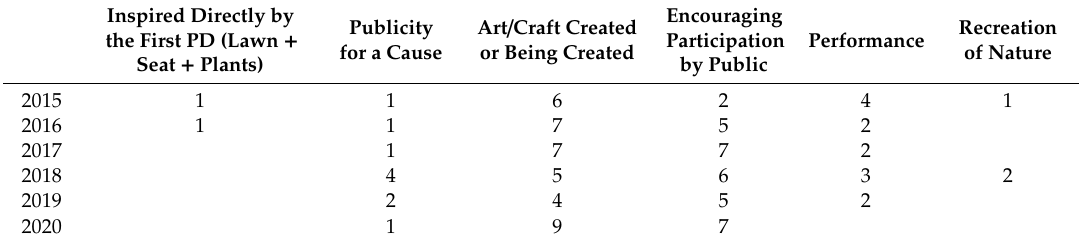
Table 4. Survey of Wellington Sculpture Trust Photo Archive of Park(ing) Day installation from years 2015–2020 showing repeating themes (not all PD installations were represented in archival photographs). Encouraging Inspired Directly by Recreation Publicity Art / Craft Created Participation Performance the First PD (Lawn + for a Cause or Being Created of Seat + Plants) by Public